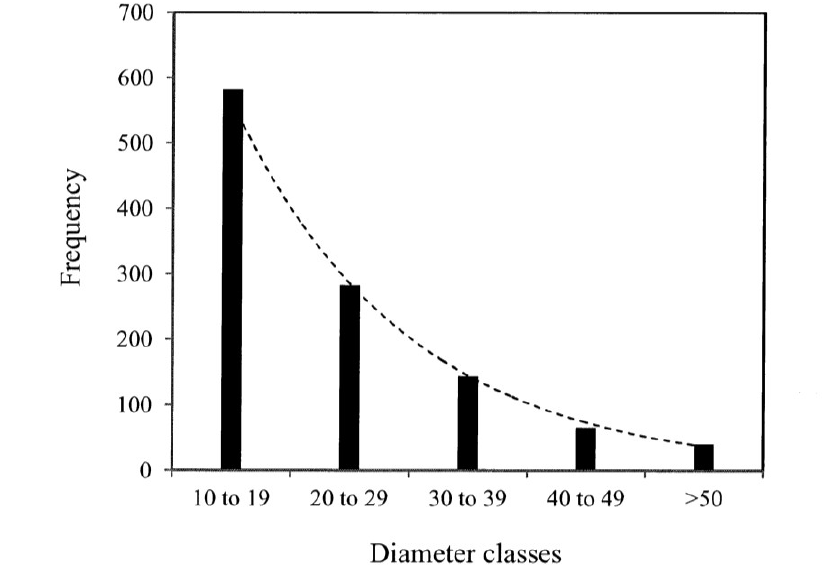
Figure 2. Frequency of stem number by diameter classes (DBH,